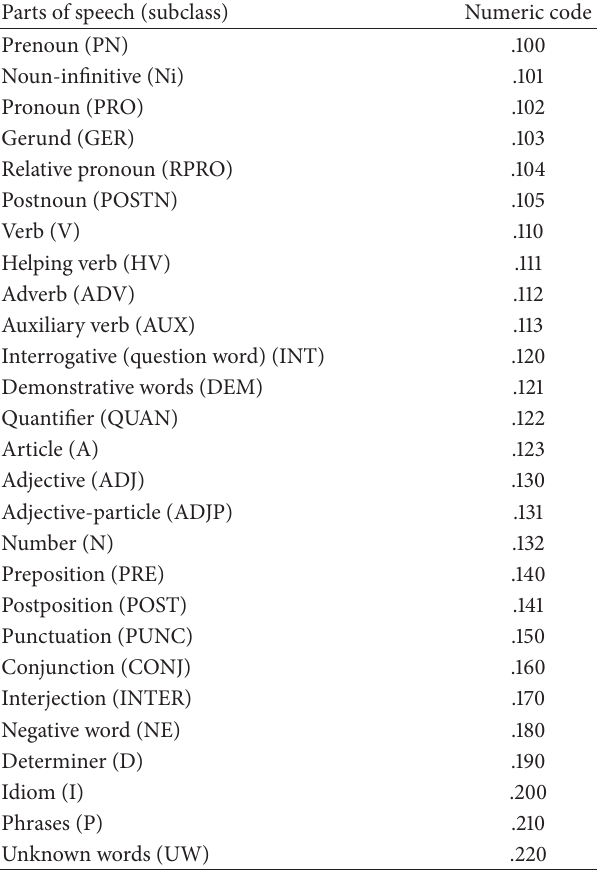
Table 1: Numeric codes for parts of